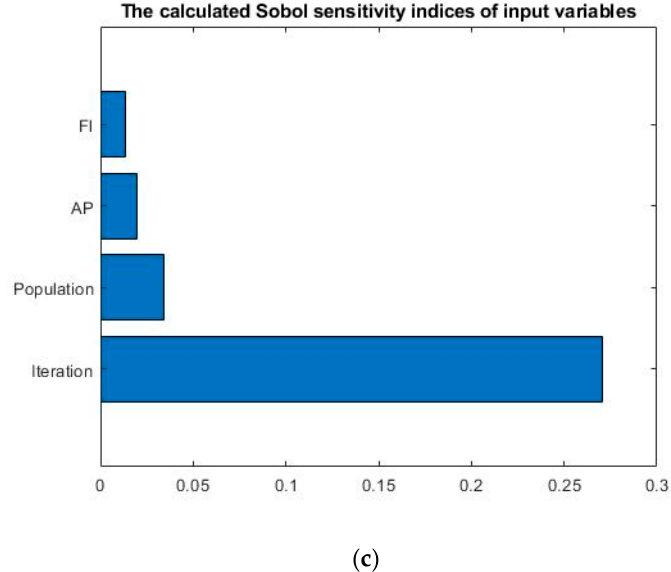
Figure 13. Sensitivity analysis on case study 2 ( a – c ), ( a ) Population vs. iteration for case study 2, ( b ) Awareness probability vs. iteration for case study 2 and ( c ) Sobol sensitivity index for case study 2.